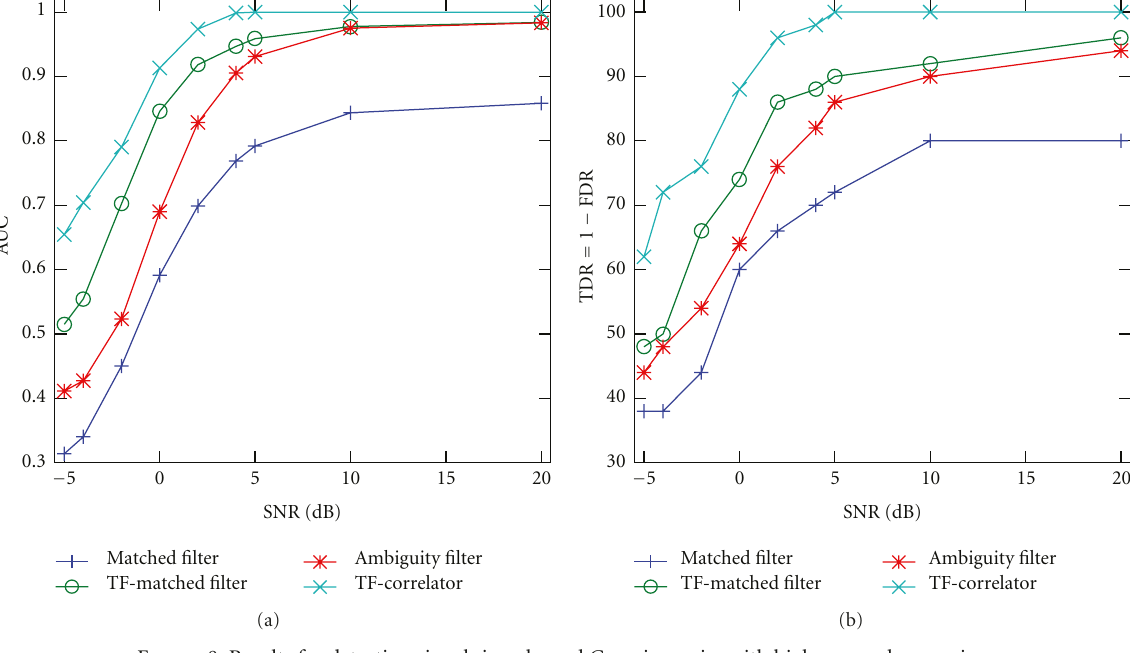
Figure 8: Results for detecting signals in coloured Gaussian noise with high-energy